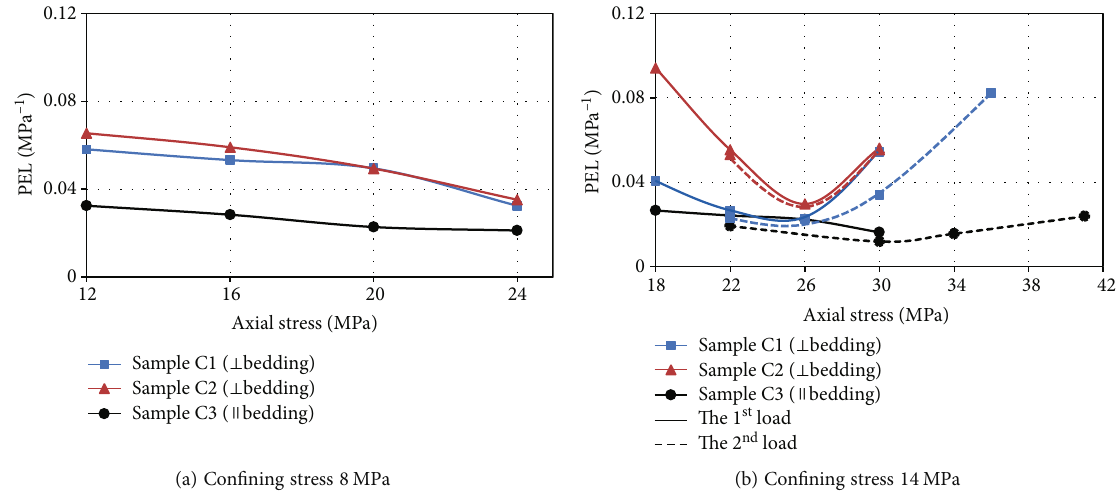
Figure 9: The PEL calculating results under cyclic deviatoric stresses.